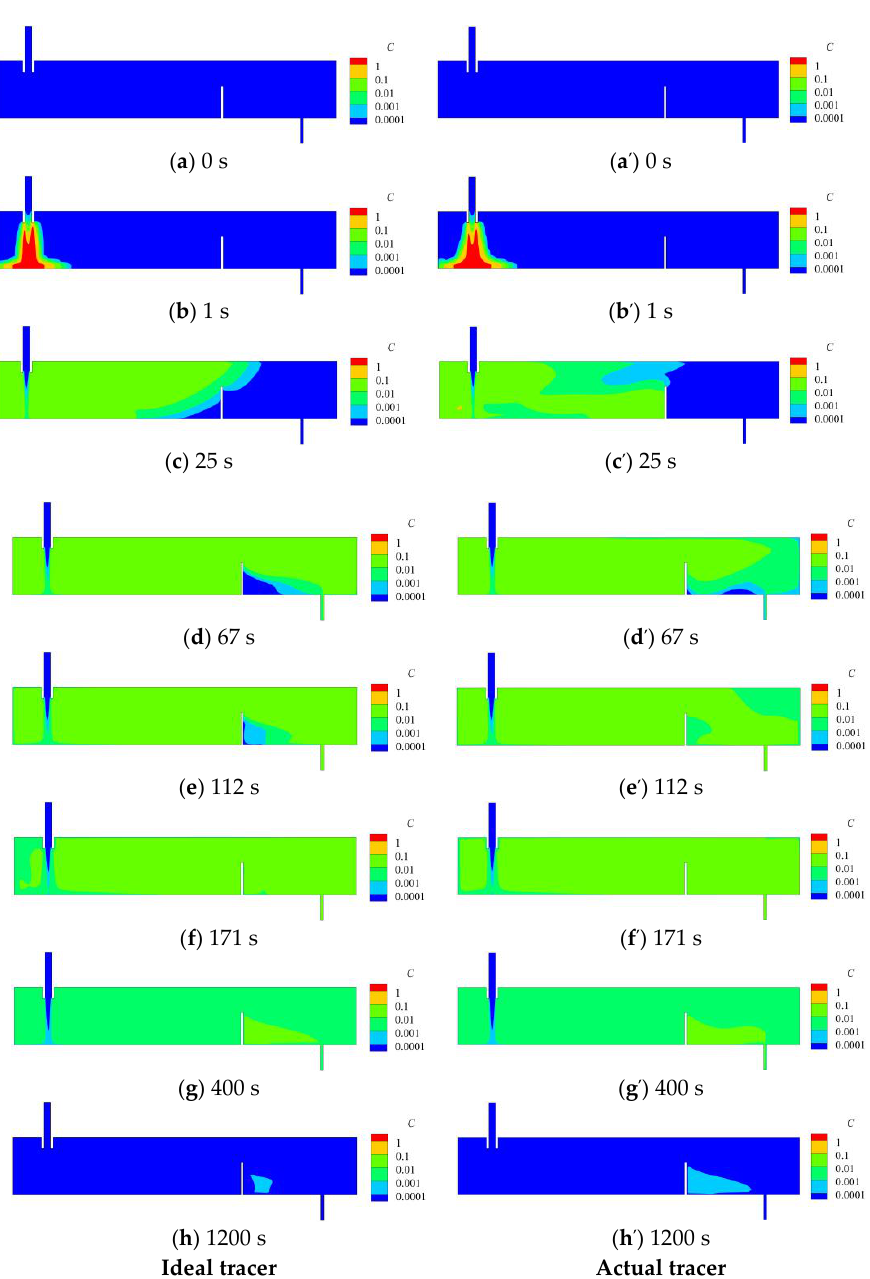
Figure 11. Tracer mass concentration distribution in tundish at different moments with solute buoyancy or not: Ideal tracer (a) 0 s; (b) 1 s; (c) 25 s; (d) 67 s; (e) 112 s; (f) 171 s; (g) 400 s; (h) 1200 s; Actual tracer (a ’ ) 0 s; (b ’ ) 1 s; (c ’ ) 25 s; (d ’ ) 67 s; (e ’ ) 112 s; (f ’ ) 171 s; (g ’ ) 400 s; (h ’ ) 1200 s.